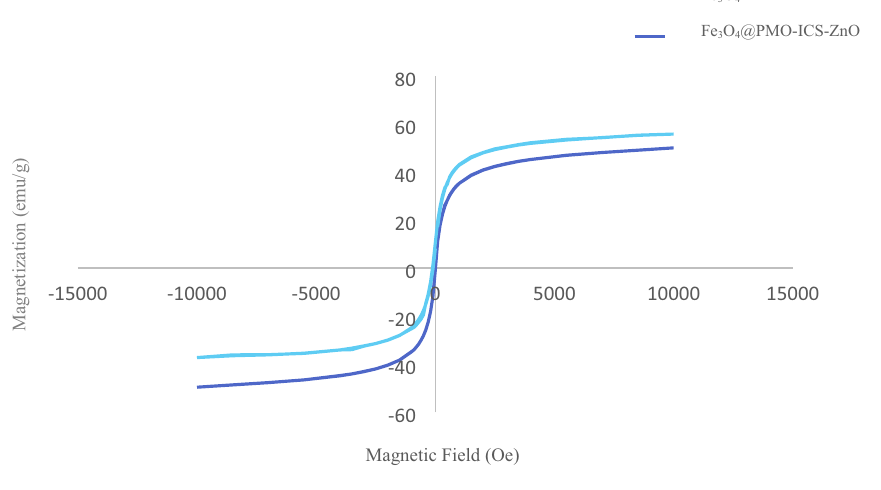
Figure 9. VSM magnetization curves for the Fe 3 O 4 and Fe 3 O 4 @PMO-ICS-ZnO ( 1